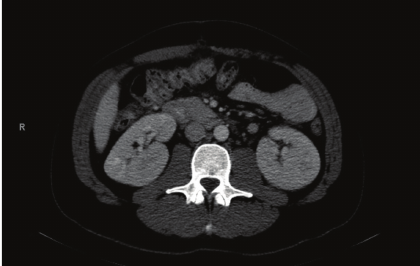
Figure 1: CT scan with oral contrast showing enlarged 15cm right kidney and 14.5cm left kidney with no hydronephrosis.